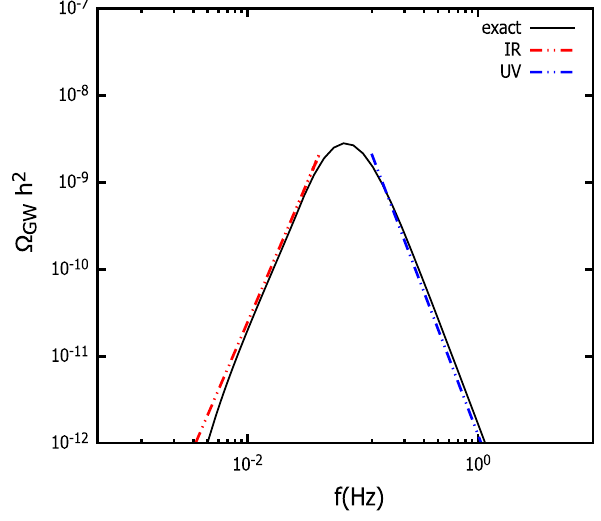
Fig. 3 The energy density of GWs for the case of modifying Wess– Zumino superpotential. Dashed lines corresponds to analytical approx- imation of the IR slope (red) and UV slope